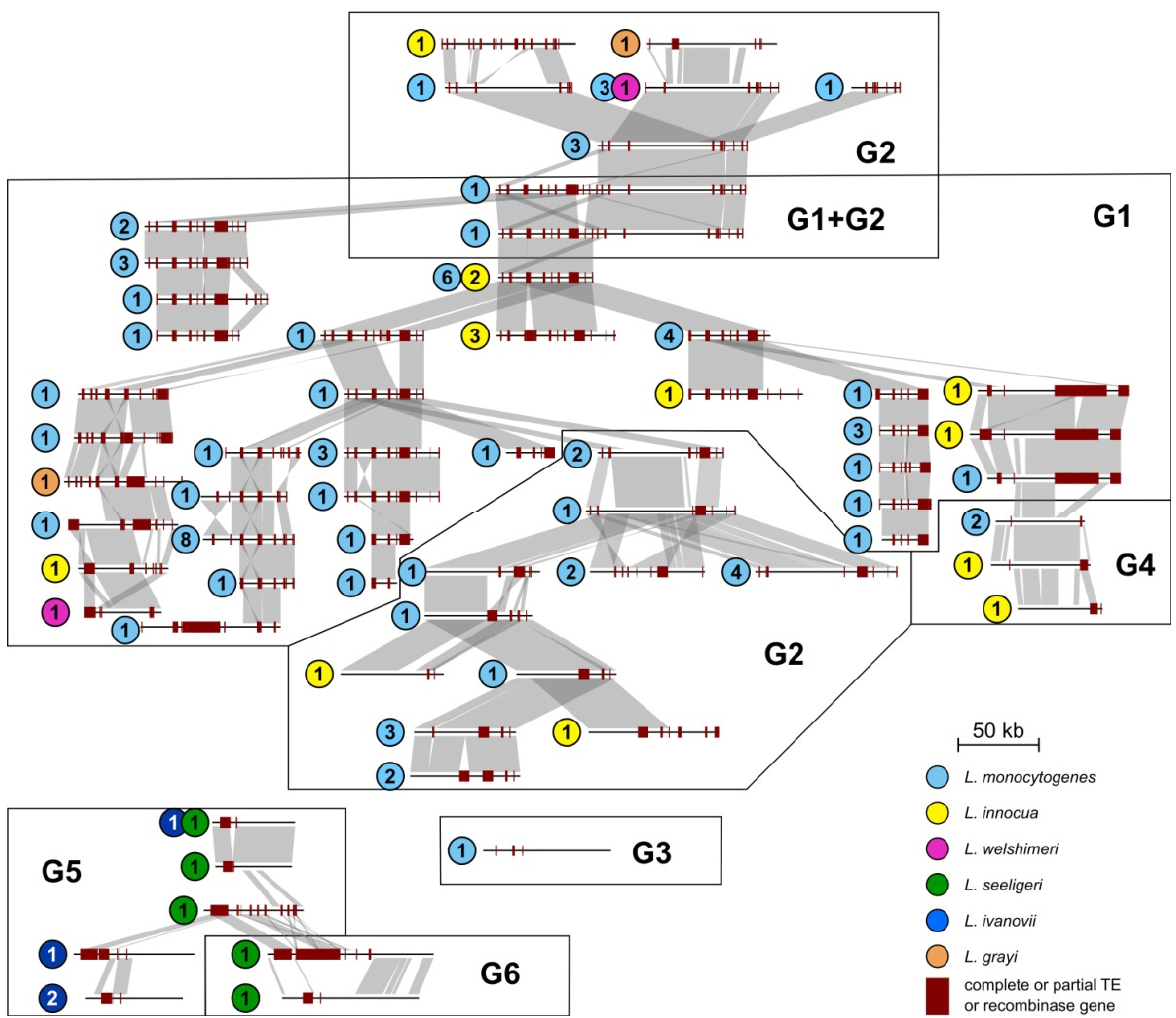
Figure 4. Conserved structure of Listeria repA ‐ family plasmids analyzed in this study. Plasmids are grouped within RepA phylogenetic clusters (G1–G6). The sequences were aligned and visualized using EasyFig. Regions of size > 1 kb and nt sequence identity > 90% are connected by gray boxes. Plasmids differing only by point mutations and small indels (of <1 kb) are grouped together and represented by one plasmid of the largest size, with circled figures indicating the number of plasmids included. Inserted TEs (complete and partial) as well as recombinase genes, which may mediate recombination events, are indicated by brown boxes.